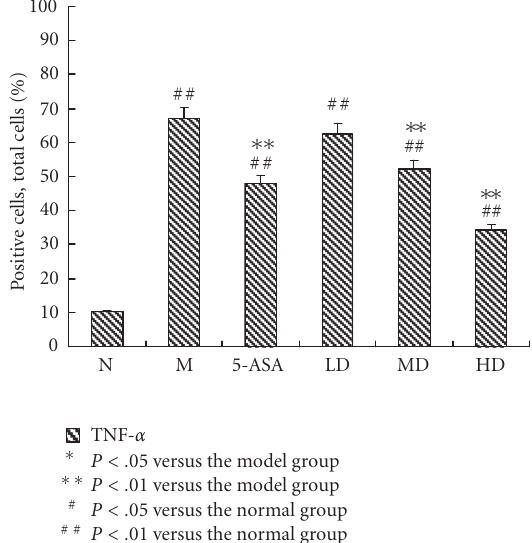
Figure 2: Immunohistochemical staining for TNF- α : (a) expression of TNF- α in the N group (brown staining, SP TNF- α in the M group (brown staining, SP